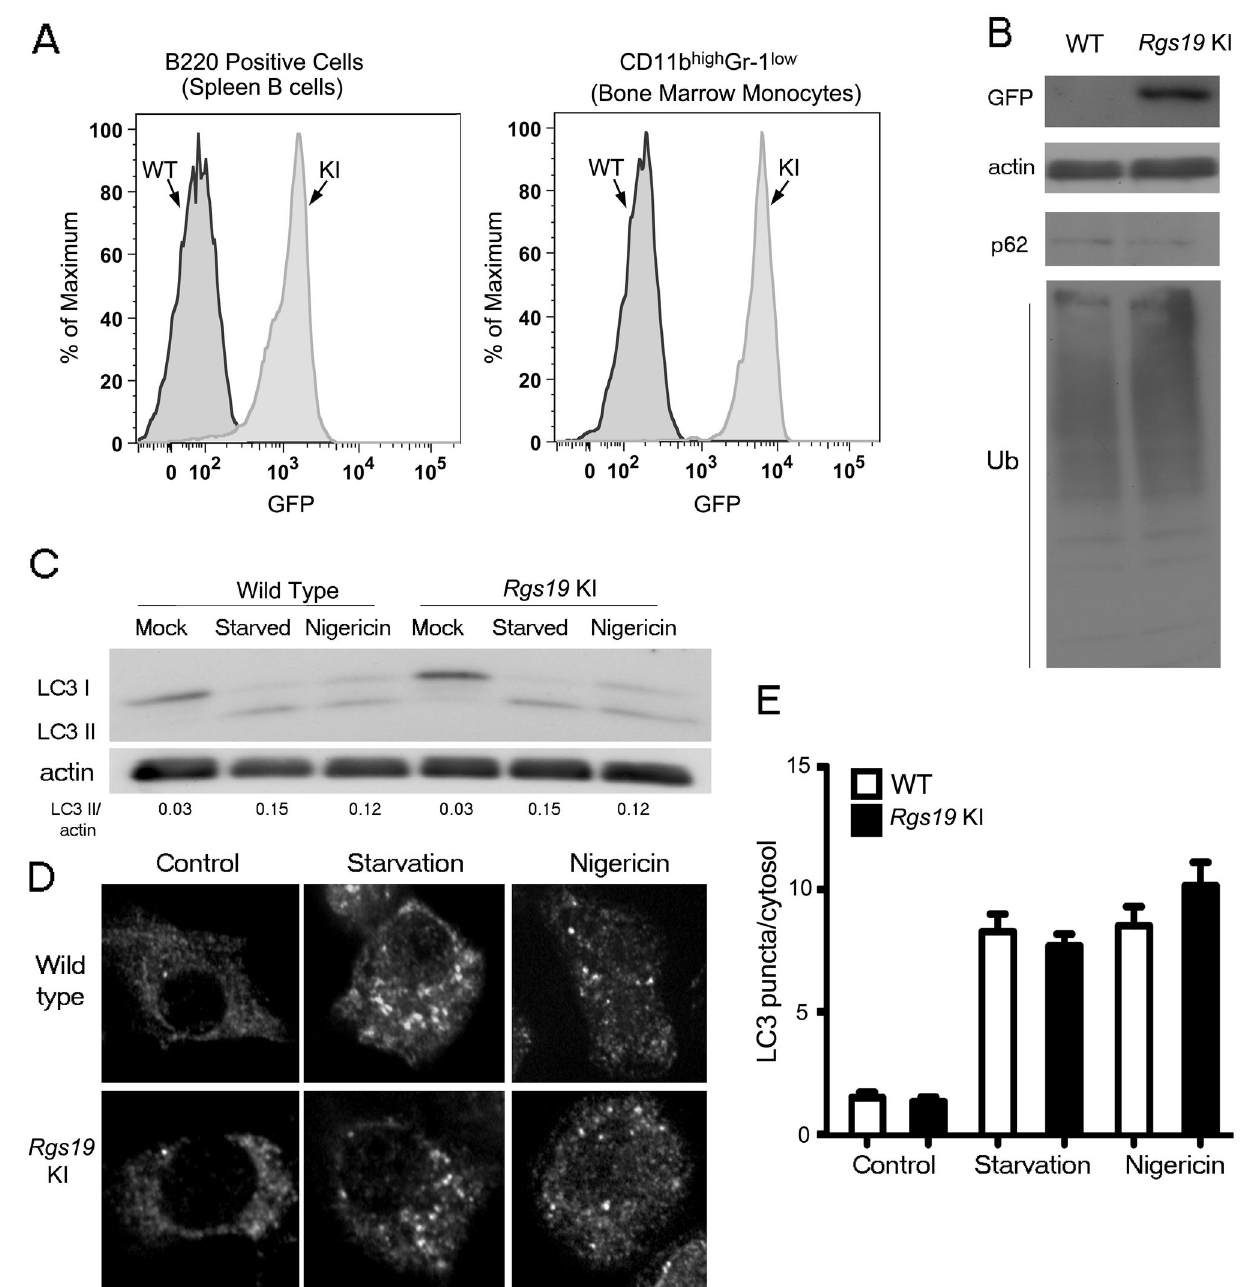
Figure 3. The lack of RGS19 does not affect autophagy induction in primary mouse macrophages. ( A ) Flow cytometry analysis of GFP expression in splenic B cells and bone marrow monocytes from Rgs19 GFP KI mice. ( B ) Immunoblot analysis of cell lysates from BMDM prepared from wild type mice or Rgs19 GFP KI mice to assess the steady state levels of Gα ubiquitin proteins. ( C ) Immunoblot analysis of cell lysates from BMDM prepared from wild type mice or Rgs19 GFP KI mice either not manipulated, starved (HBSS for 1 h with 100 nM Bafilomycin A1), or treated with nigericin (4 µM for 4h) to assess LC3-II/actin band ratios. ( D ) Endogenous LC3 immunocytochemistry of BMDM from wild type mice or Rgs19 GFP KI mice either not manipulated, starved (HBSS for 1 hour with 100 nM Bafilomycin A1), or treated with nigericin (4 µM for 4 hours). Representative images are shown for each condition. ( E ) Quantification of endogenous LC3 dots performed by fluorescence microscopy for at least 70-100 cells from experiment shown in part C. Data represents the mean LC3 puncta per cytosol ± SEM for three independent experiments for each condition.